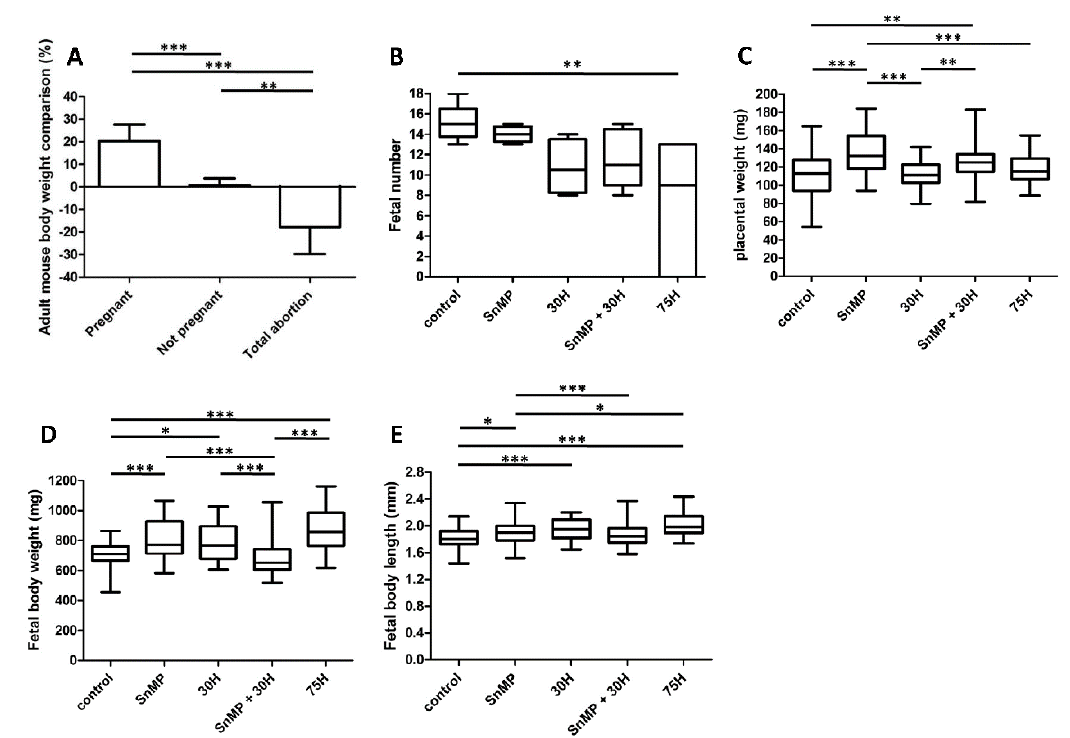
Figure 2. Adult mouse body weight comparison, fetal number, fetal body weight and placental weight a ff ected by HO-activity inhibition and heme administration. ( A ) Bar chart for the adult mouse body weight comparison, the percentage (%) of the weight change between Days E12 and E15. Unfortunately, the weight at Day E15 was unintentionally not collected from two pregnant mice (75H group) and two mice that demonstrated abortion (SnMP + 75H and 75H groups). Eventually, the body weight comparison of the pregnant mice ( n = 22; control n = 6, SnMP n = 4, 30H n = 4, SnMP + 30H n = 5, 75H n = 3), not pregnant mice ( n = 5; SnMP = 1, 30H n = 2, SnMP + 30H n = 2) and mice that demonstrated total abortion ( n = 7; 75H n = 1, SnMP + 75H n = 3, 150H n = 3) was calculated. Data are shown as mean ± SD. ( B ) Box-and-whisker plot with 10–90 percentiles of quantitative assessment of the fetal number (number of fetuses per pregnant mouse of the di ff erent groups). Number of pregnant mice per group; control n = 6, SnMP n = 4, 30H n = 4, SnMP + 30H n = 5, 75H n = 7. Number of fetuses per group: control n = 91, SnMP n = 56, 30H n = 43, SnMP + 30H n = 58, 75H n = 46. ( C ) Box-and-whisker plot with 10–90 percentiles of quantitative assessment of the placental weight of the di ff erent groups (control n = 91, SnMP n = 56, 30H n = 43, SnMP + 30H n = 58, 75H n = 46). Box-and-whisker plot with 10–90 percentiles of quantitative assessment of the ( D ) fetal body weight and ( E ) fetal body length of the fetuses of the di ff erent groups (control n = 91, SnMP n = 56, 30H n = 43, SnMP + 30H n = 58, 75H n = 46) were measured. * p < 0.05, ** p < 0.01, *** p < 0.001.